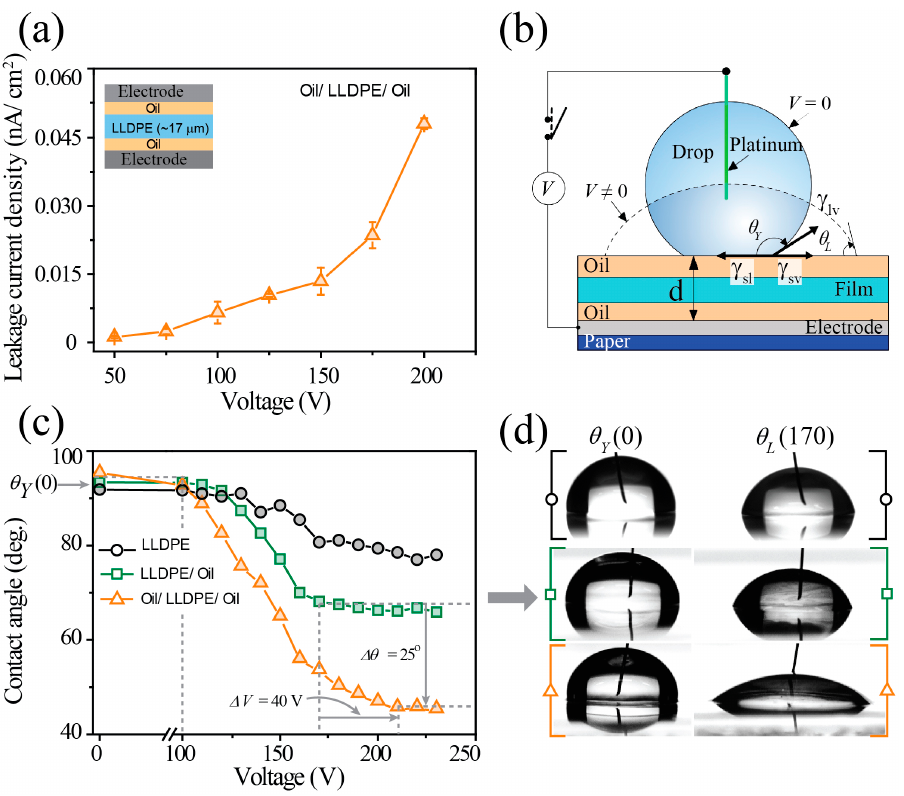
Figure 4. ( a ) Leakage current density across the LLDPE-dielectric film and its schematic measurement (inset). Characterization of the electrowetting on dielectric (EWOD) experiment on the LLDPE-dielectric film: ( b ) EWOD setup, and ( c , d ) the electro-spreading of the drop under applied voltages.